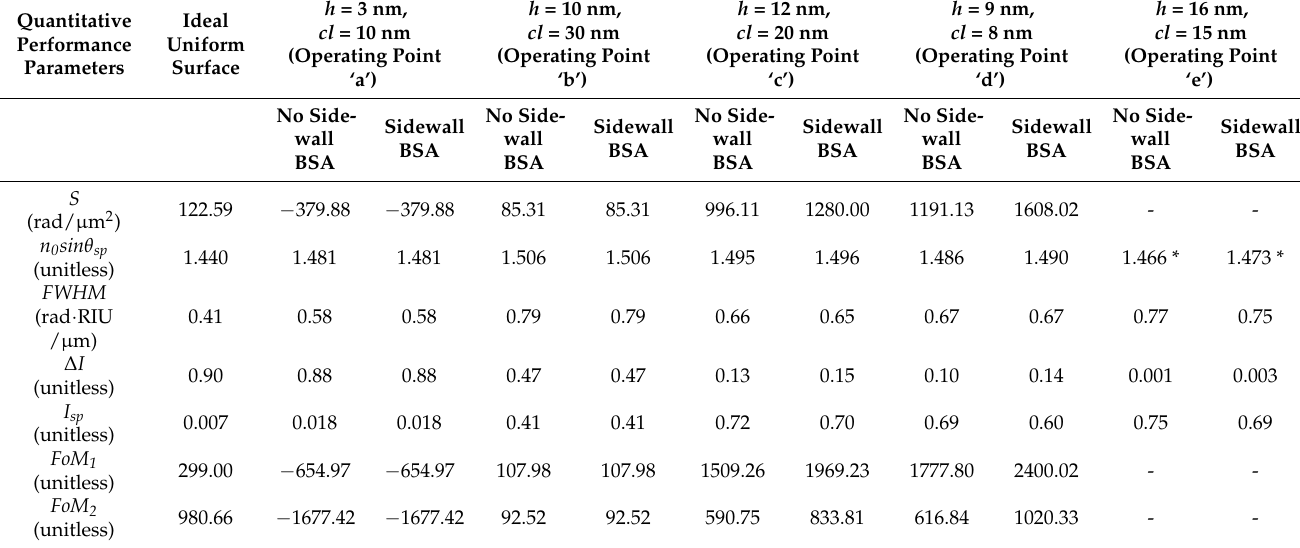
Table 3. The quantitative performance parameters comparison between the surface plasmon reso- nance detection employed with a uniform and rough gold